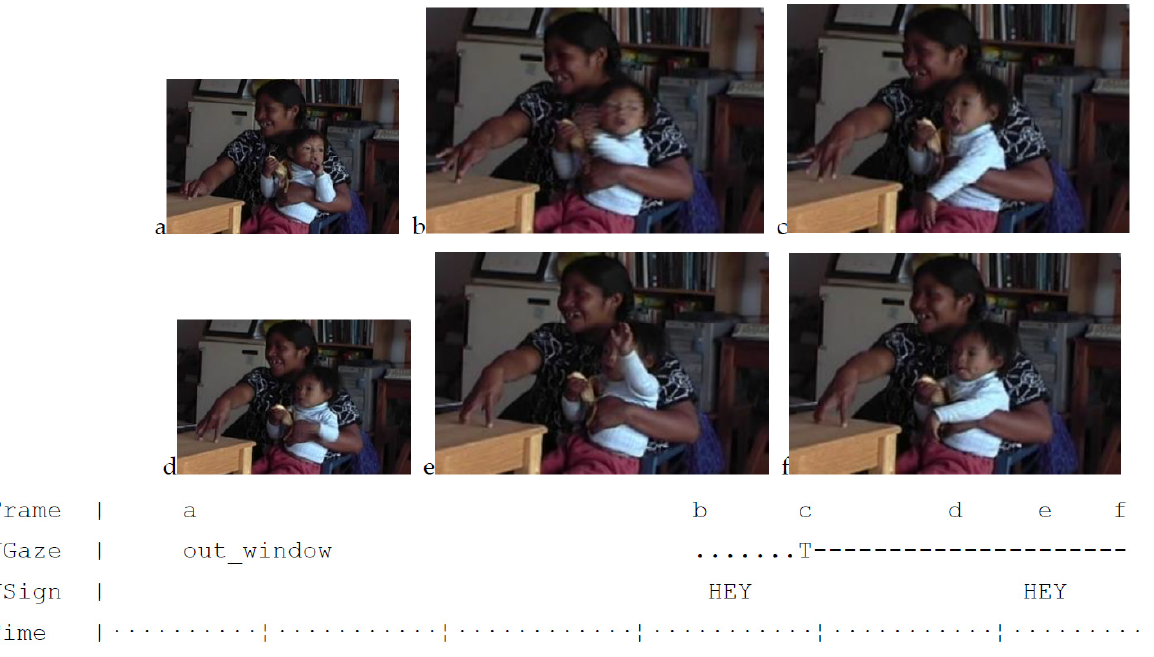
Figure 14. At 17 mos. Vic issued an empty summons. ( a , b ) Vic turns to look at his intended interlocutor, ( c ) immediately completing a sharp downward sweep of his arm very much like the COME gesture, and then ( d – f ) repeating it.